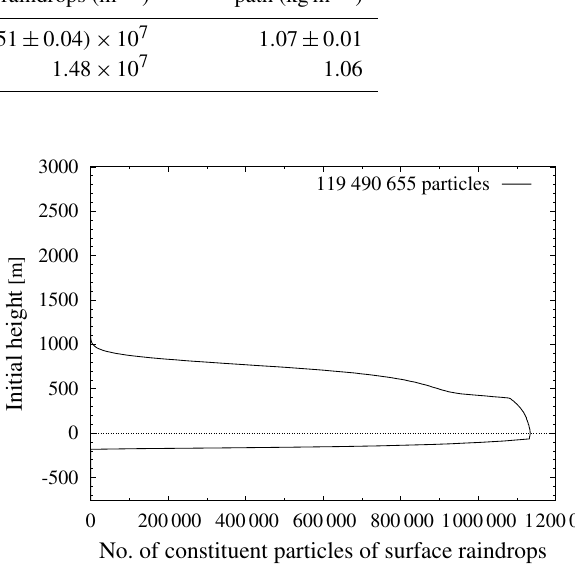
Figure 4. Initial locations of the particles that comprise the surface raindrops of the 30 NORM runs. The vertical distribution of the 119490655 particles that make up the 36018 surface raindrops is drawn. The particles that are initially at negative height (near the top boundary) can be considered in the same manner as those that are transported into the domain along, or generated near, the